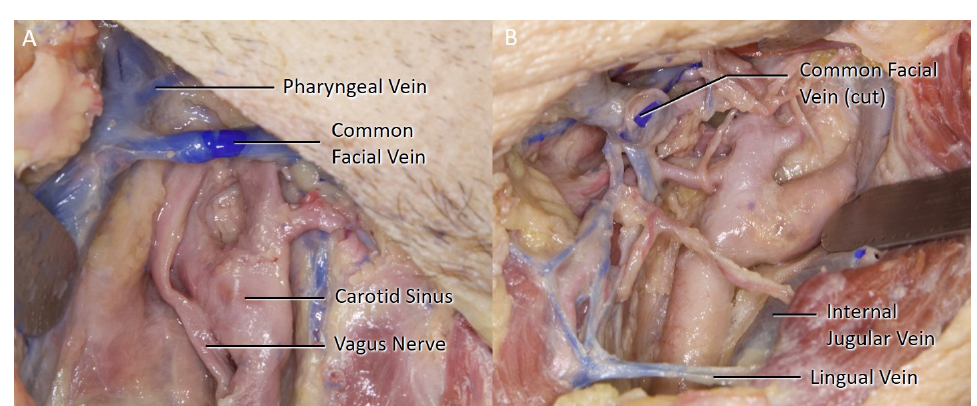
Figure 2. ( A ) A direct right side pharyngeal vein along with a common facial vein can be seen. ( B ) A left side cut common facial vein, a direct lingual vein inferiorly and the venous interconnections medially (left) can be